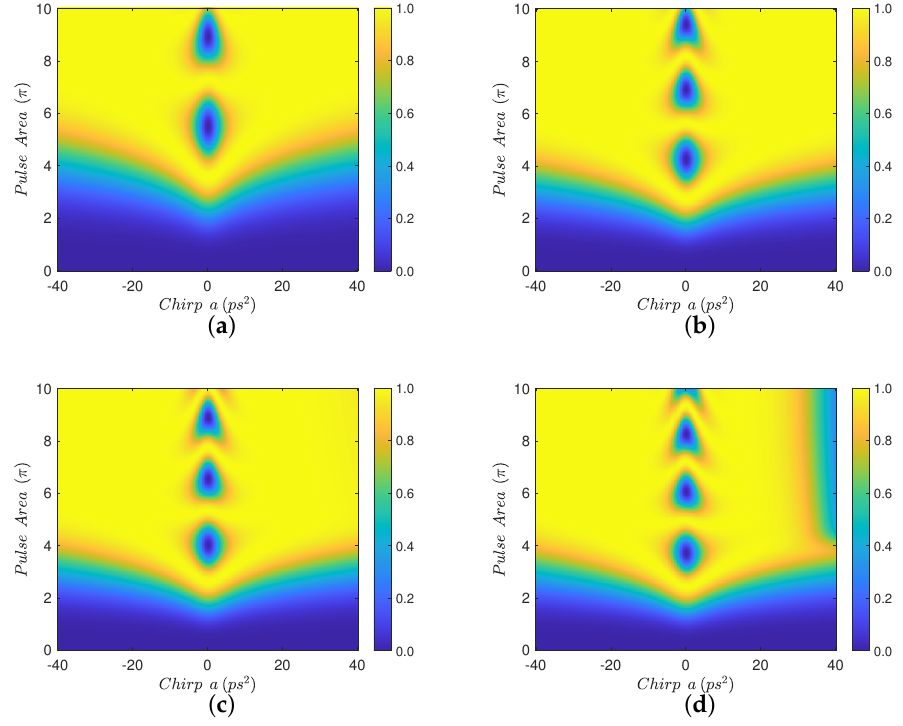
Figure 7. Contour diagrams for the biexciton population at the final time, as function of the pulse area and the chirp parameter a of the applied Gaussian pulse, with biexciton energy shift E b = − 3 meV, initial Gaussian pulse duration τ 0 = 2 ps, and four different interparticle distances: ( a ) R = 100 nm, ( b ) R = 15 nm, ( c ) R = 14 nm, and ( d ) R = 13